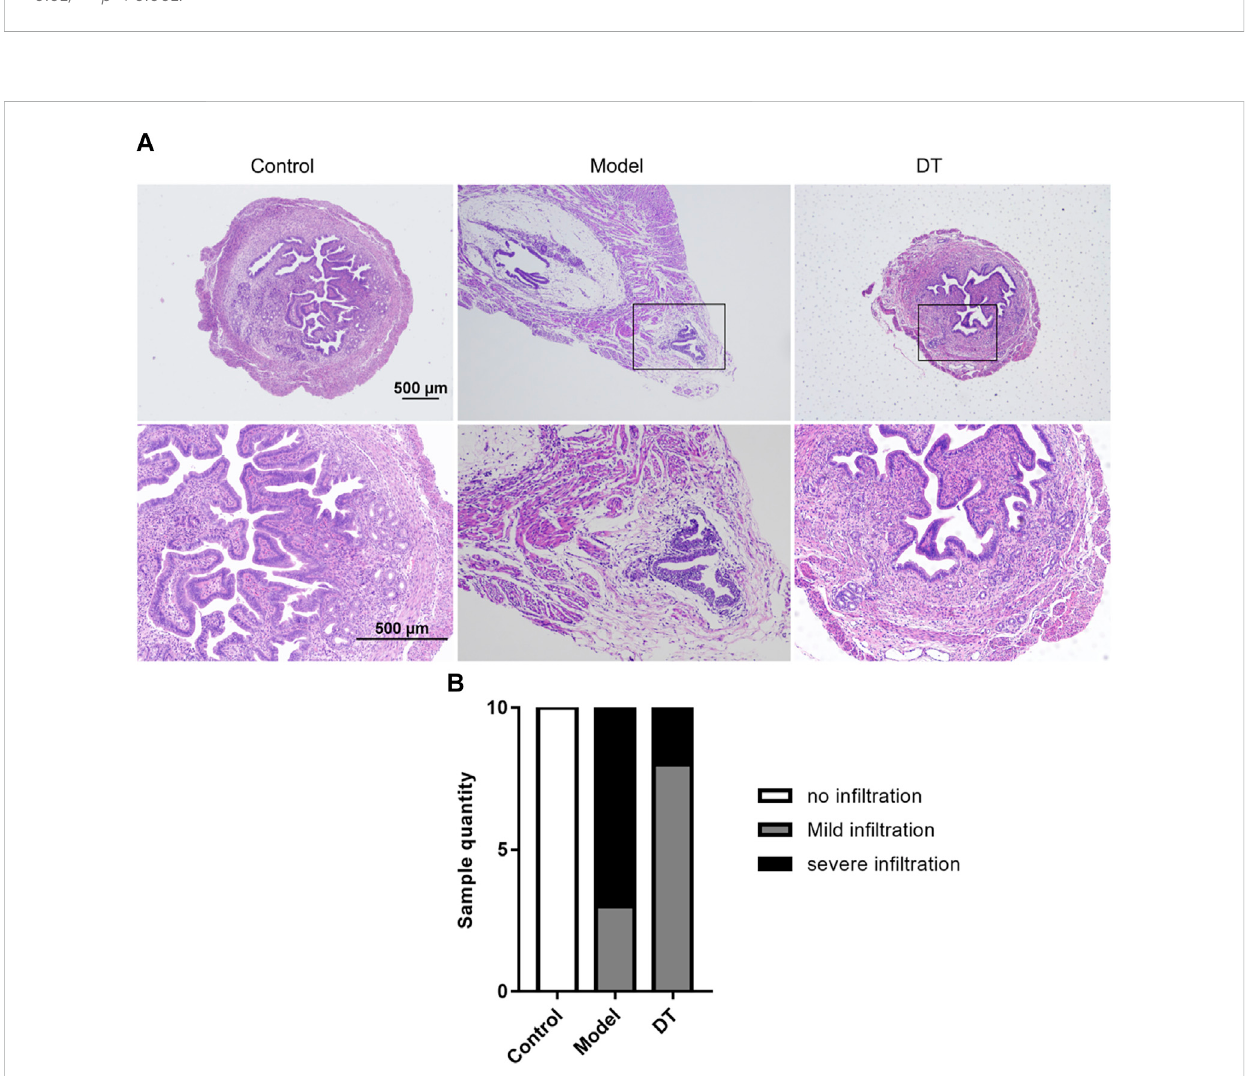
FIGURE 7 (A) Representative microscopic images of the uterus of normal mice (Control) and AM mice treated (DT) and untreated with DT (Model). (B) The number of mice quanti fi ed the representative relative degree of in fi